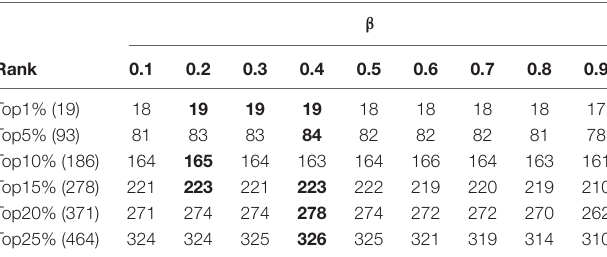
TABLE 3 | Effect of parameter β on prediction performance of LNSPF in Gavin database.